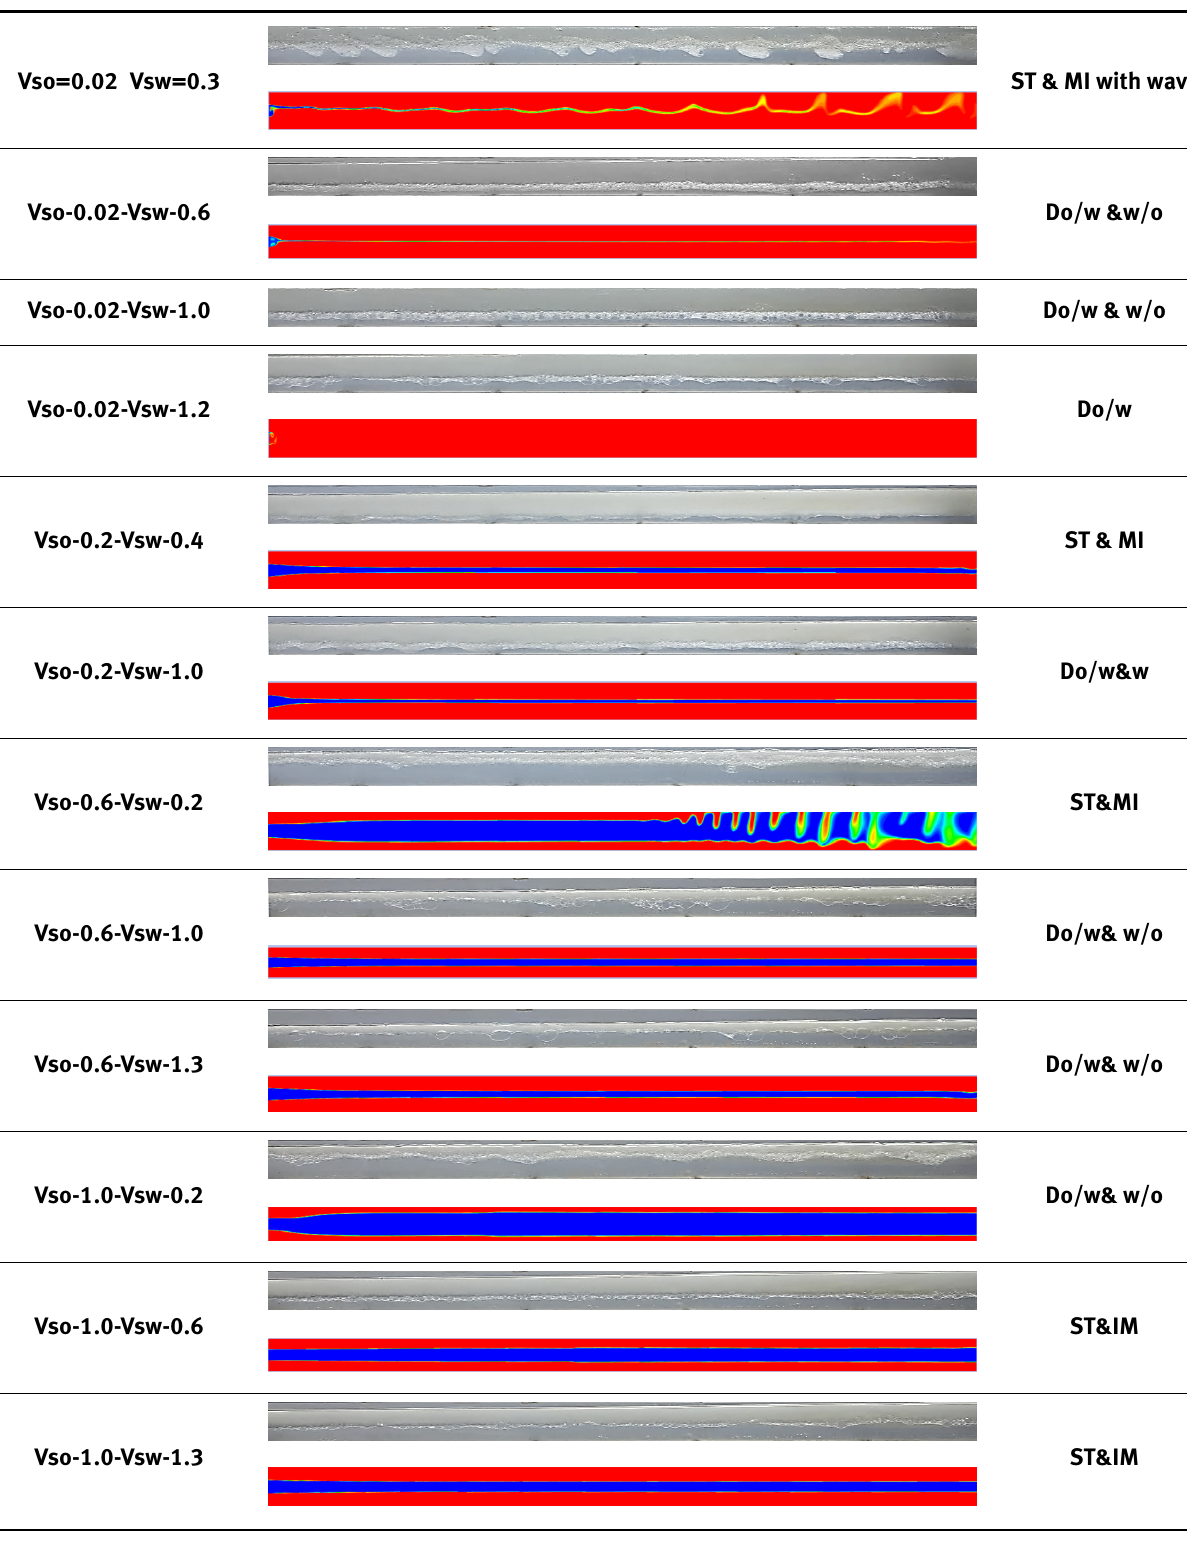
Vso=0.02 Vsw=0.3 ST & MI with wavy